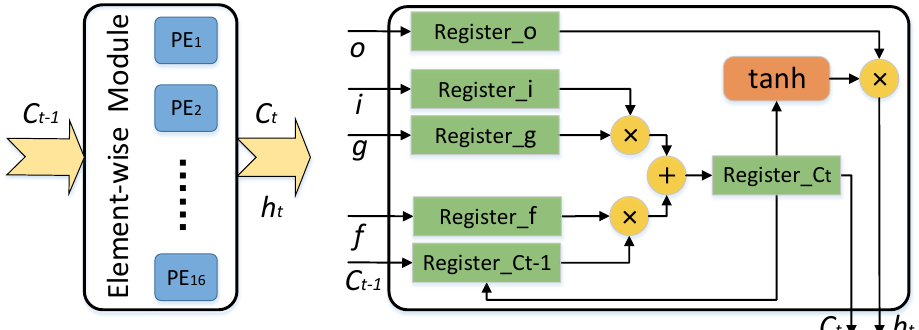
Figure 7. The structure of the element-wise